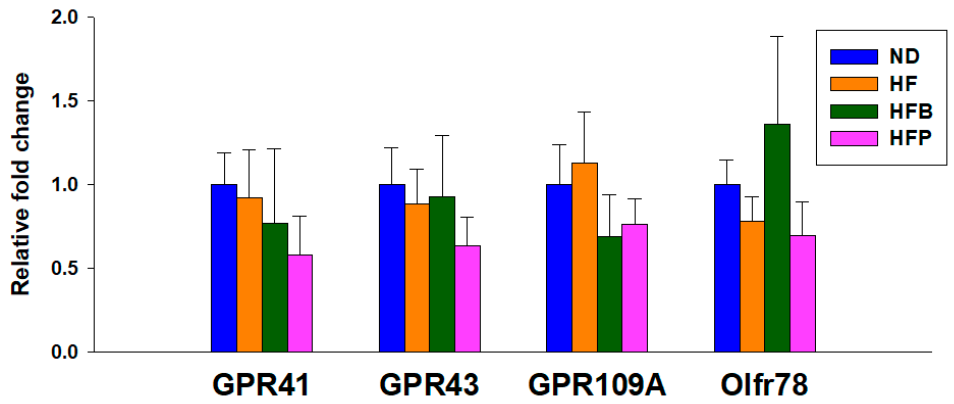
Figure 2. Renal mRNA expression of G protein-coupled receptor 41 (GPR41), GPR43, GPR109A, and olfactory receptor 78 (Oflr78) of male offspring at 12 weeks of age. n = 8/group. olfactory receptor 78 (O fl r78) of male o ff spring at 12 weeks of age. N = 8/group.